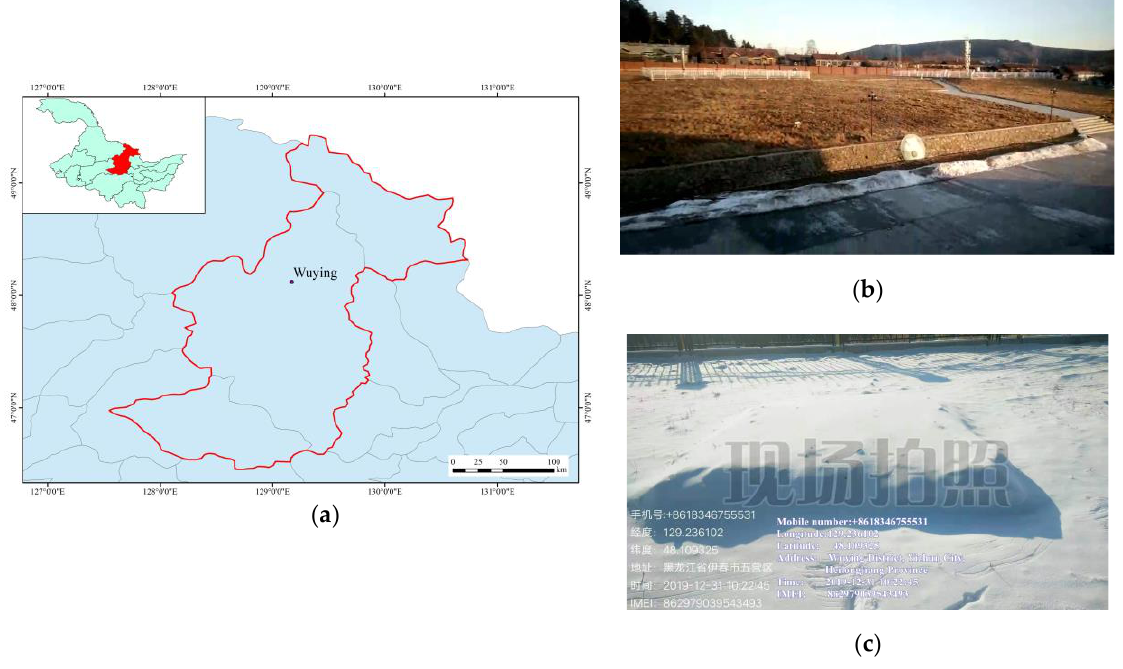
Figure 1. The test area. ( a ) The location of experiment quadrats; ( b ) The quadrats before experiment; ( c ) The quadrats during experiment.